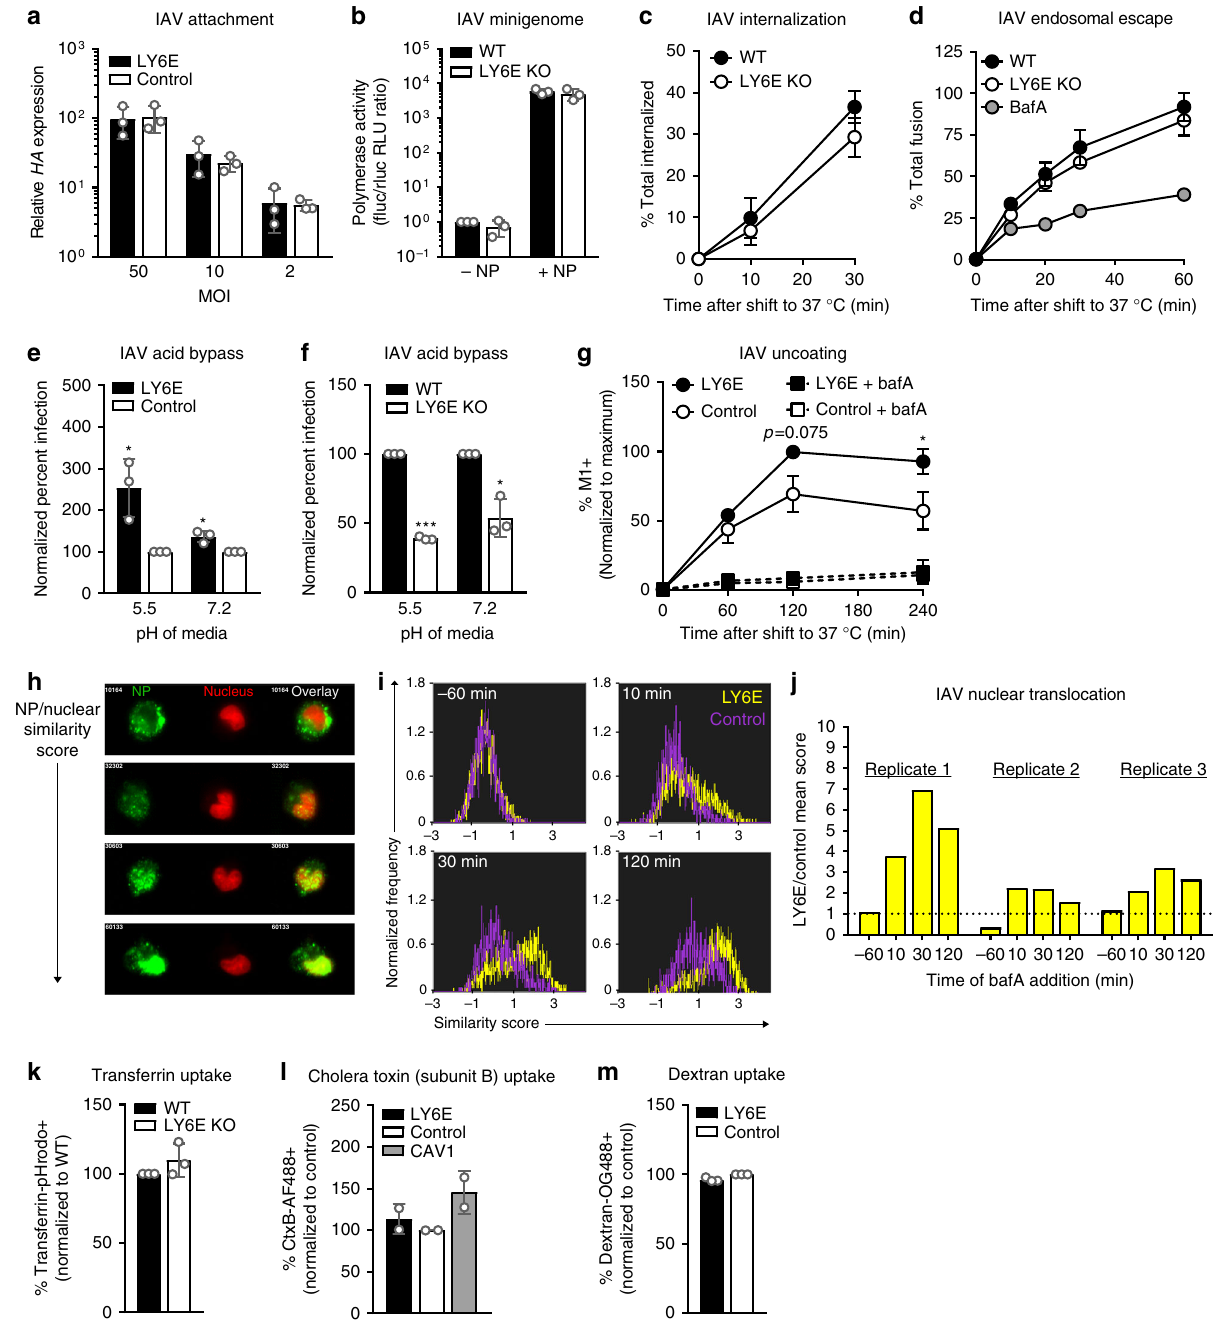
Fig. 5 LY6E enhances entry of in fl uenza A virus at the step of uncoating. a Cold-bind of IAV with STAT1 -/- fi broblasts. HA expression is shown relative to that of control cells infected with 50 MOI IAV. n = 3 biological replicates. b IAV minigenome activity in U2OS cells. The fl uc/rluc RLU ratio is shown normalized to the WT, no NP (-NP) condition. n = 3 biological replicates. c Internalization of biotinylated IAV with U2OS. Percentage of IAV internalization was calculated relative to the signal from cells not treated with TCEP. n = 2 biological replicates. d Endosomal escape of R18-labeled IAV with U2OS.